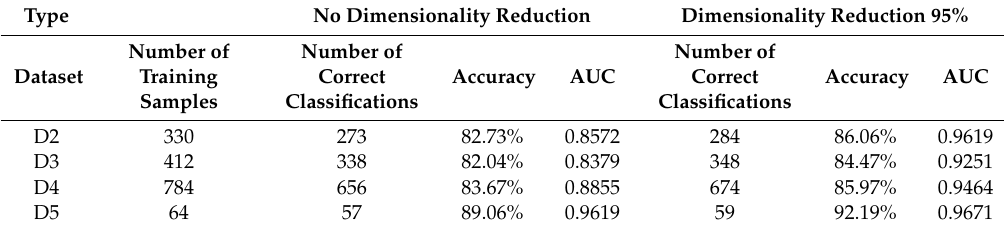
Table 7. Comparison of the results of the surface crack classification using PCA to reduce the dimensions to 95% of the original variance and no dimensionality reduction.